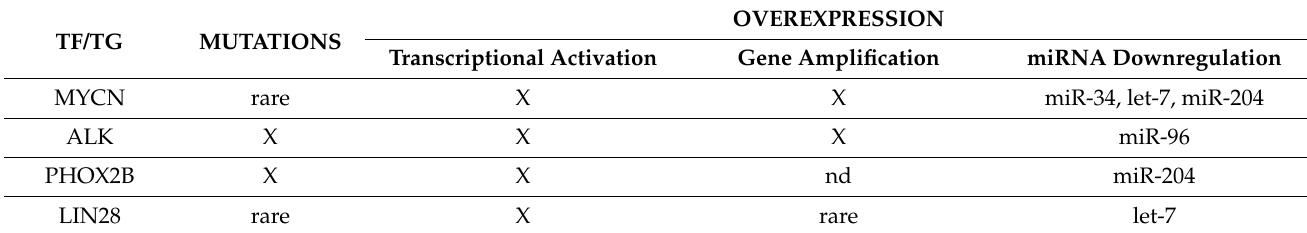
Table 1. Summary of the molecular machanisms underlying TF/TG dysregulated expression in NB. OVEREXPRESSION TF/TG MUTATIONS Transcriptional Activation Gene Amplification miRNA Downregulation MYCN rare X X miR-34, let-7, miR-204